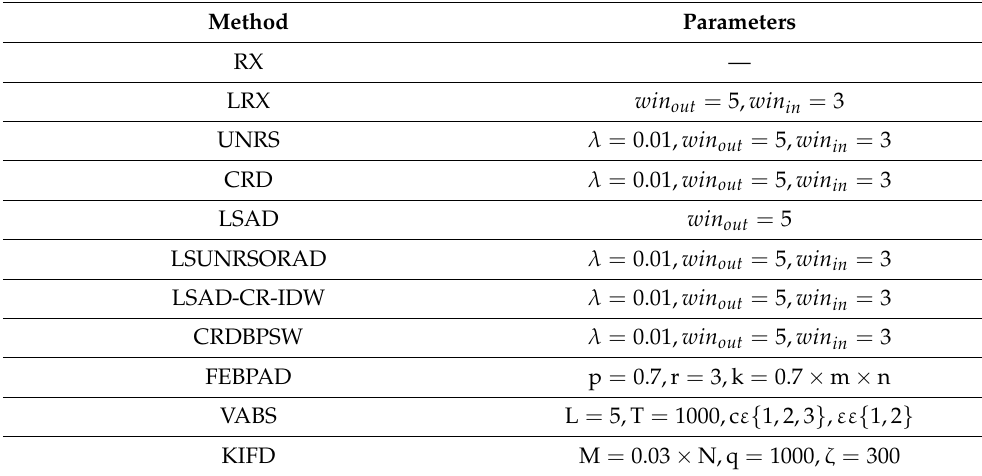
Table 2. Parameters of different detection